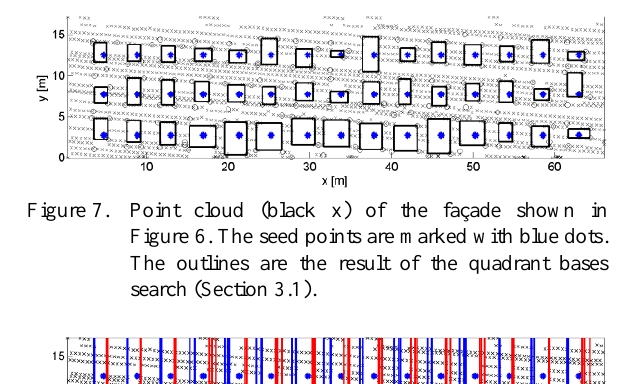
Figure 6. Image of the façade used as example in Section 4.2